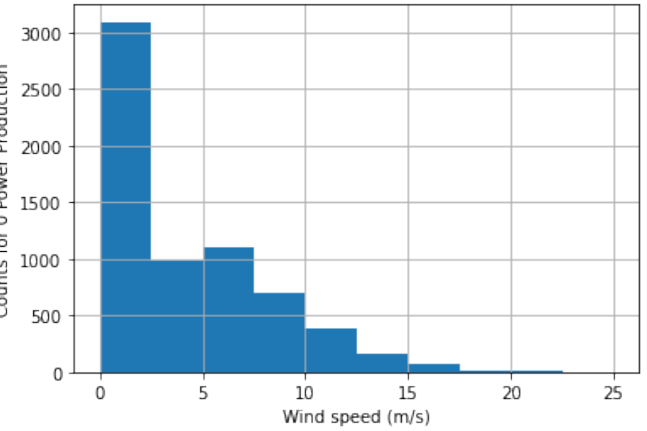
Figure 9. Count of records where wind speed was recorded, but power was zero.